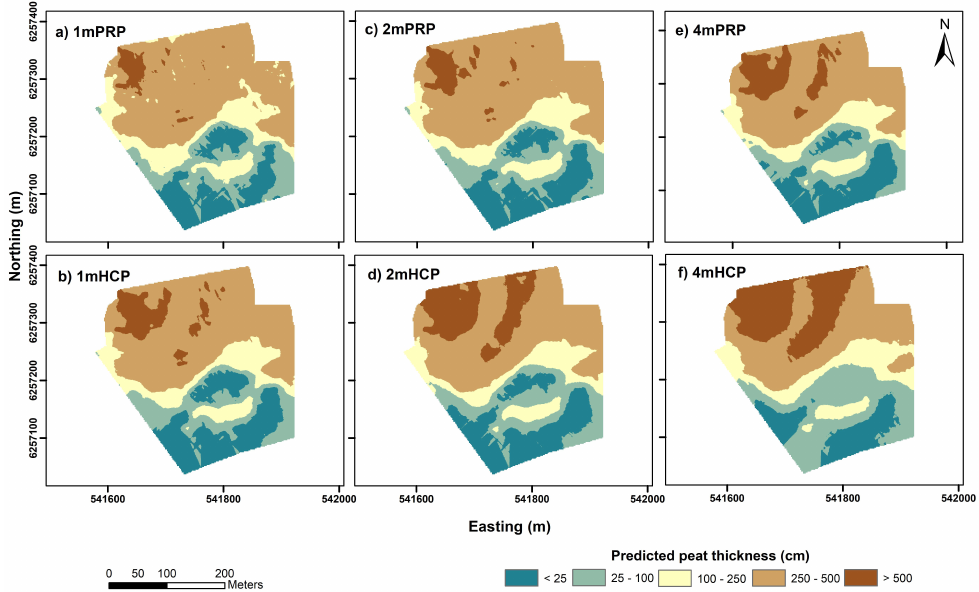
Figure 12. Contour plots of the interpolated peat thickness (cm) predicted from the apparent electrical conductivity (EC a —mS/m) collected using the six different coil configurations of a DUALEM-421S instrument: ( a ) 1mPRP, ( b ) 1mHCP, ( c ) 2mPRP, ( d ) 2mHCP, ( e ) 4mPRP and ( f ) 4mHCP